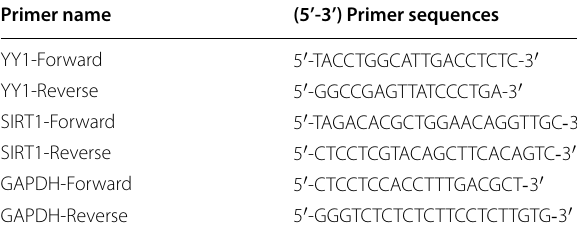
Table 1 Primer sequences for